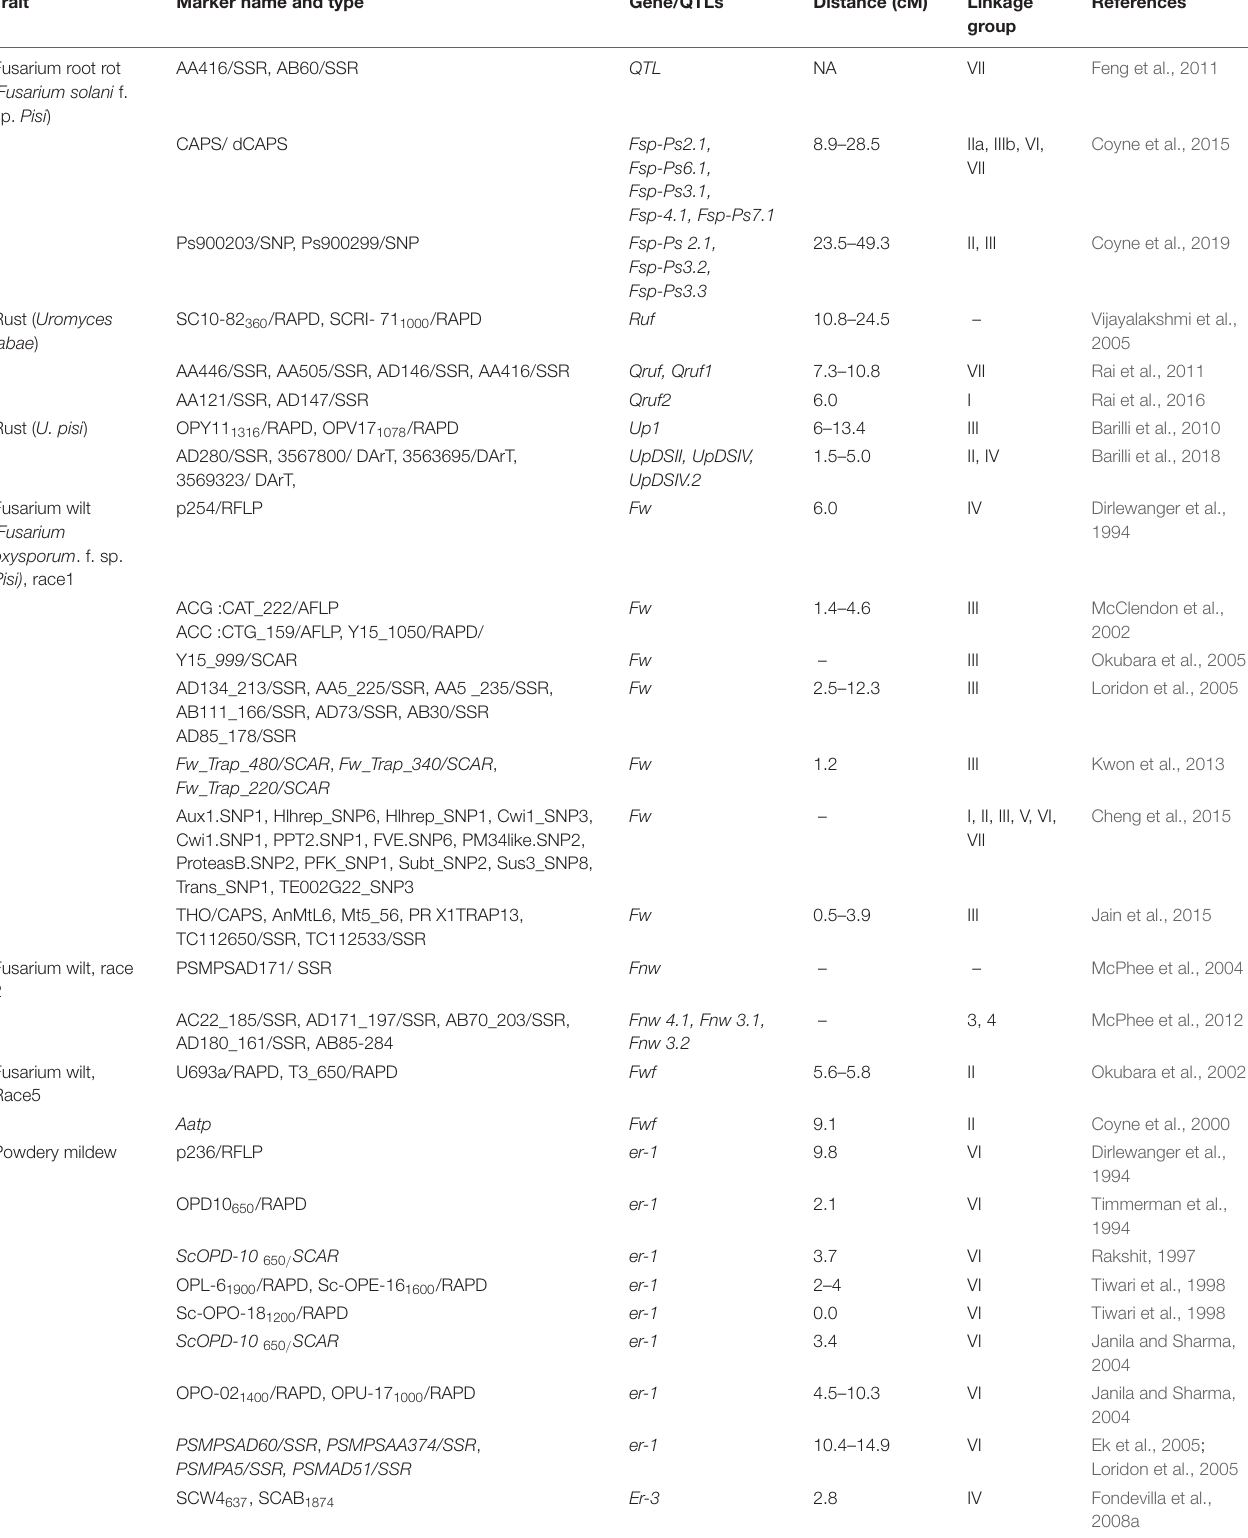
TABLE 3 | Genomic region or markers associated with resistance to different biotic stresses in field pea ( Pisum sativum L.).